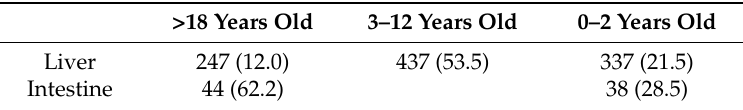
Table 3. Expression of FcRn protein in human liver and intestine tissue.